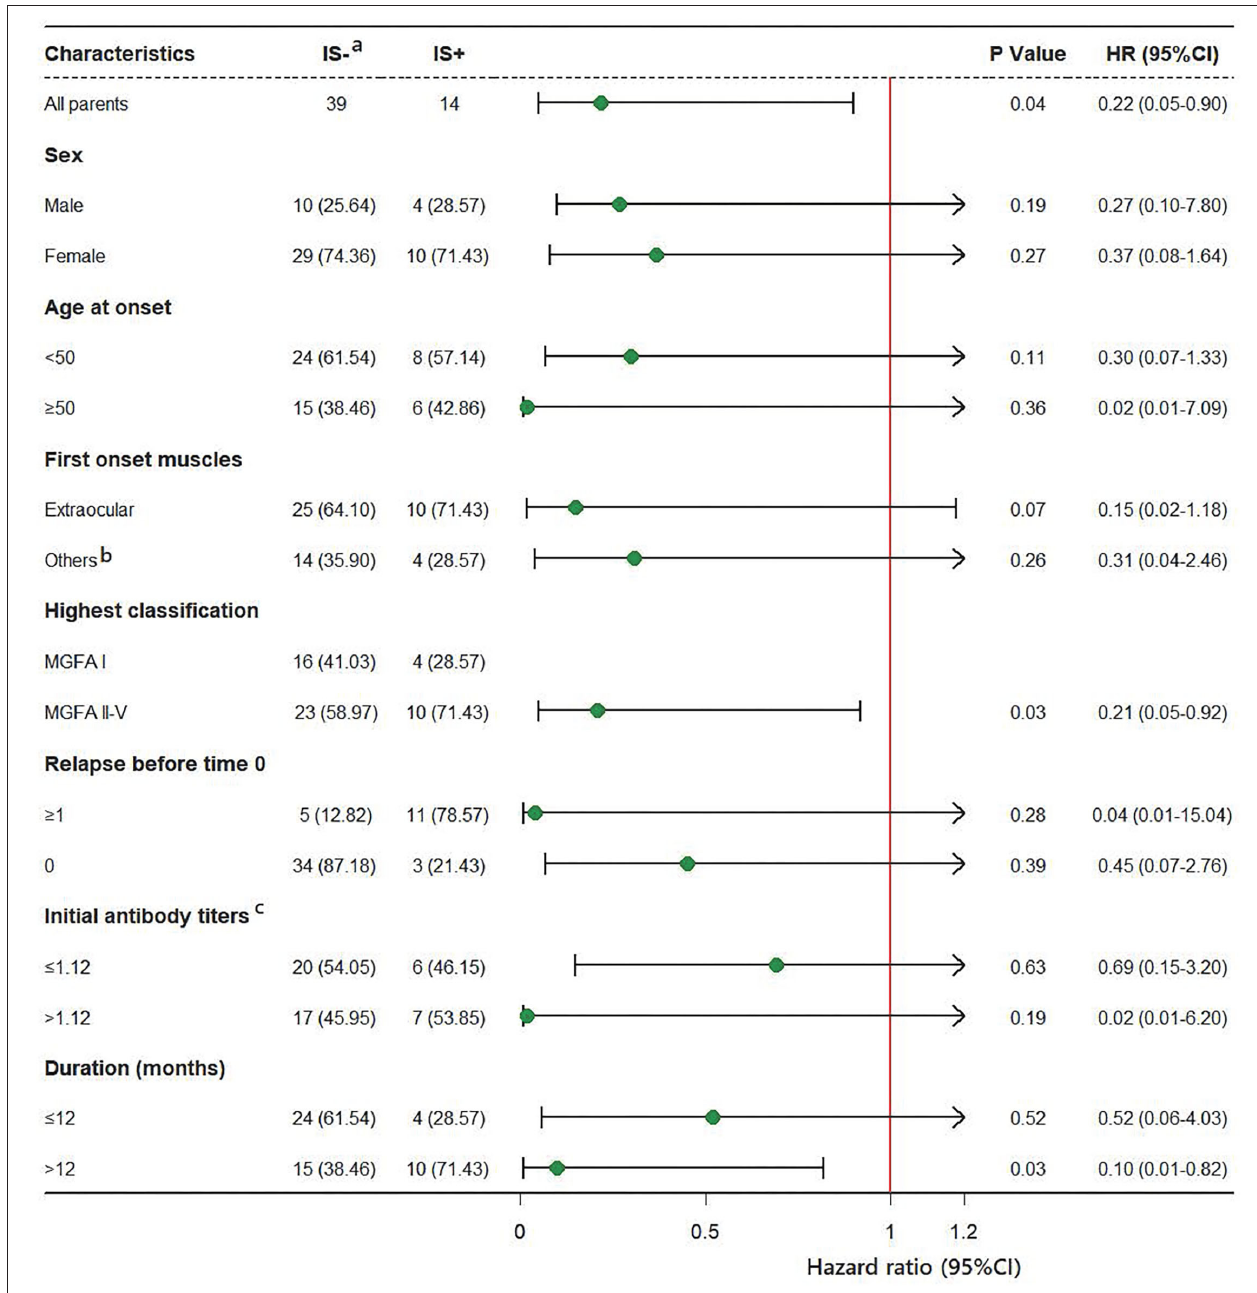
FIGURE 3 | HRs for relapse in subgroup analysis. (a) Data of group IS- used as a reference. (b) Other muscle groups: bulbar muscles, facial muscles, limb muscles and neck muscles are involved. (c) Three missing data